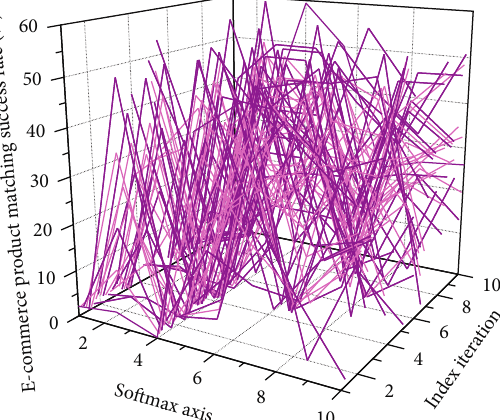
Figure 5: Distribution of the e-commerce product matching success rate.